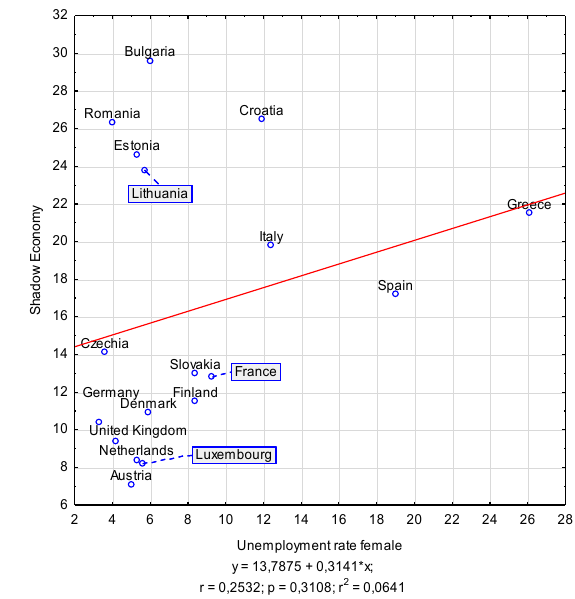
Figure 2. Regression model for shadow economy in terms of employment rate for women in the selected European Union countries